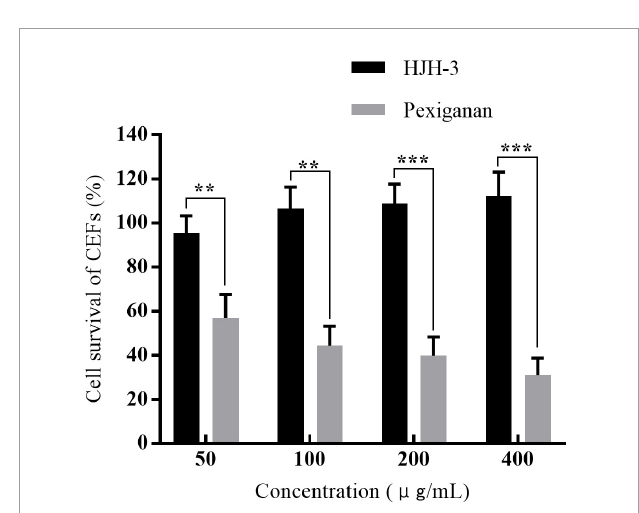
FIGURE4 The survival rates of chicken embryo fibroblasts (CEFs) cells treated with HJH-3 and pexiganan (50, 100, 200, and 400 µ g/mL) by CCK-8 assay. Results are expressed mean ± SEM and the statistical analysis was performed using the Unpaired Student’s t -test. ** P < 0.01, *** P <